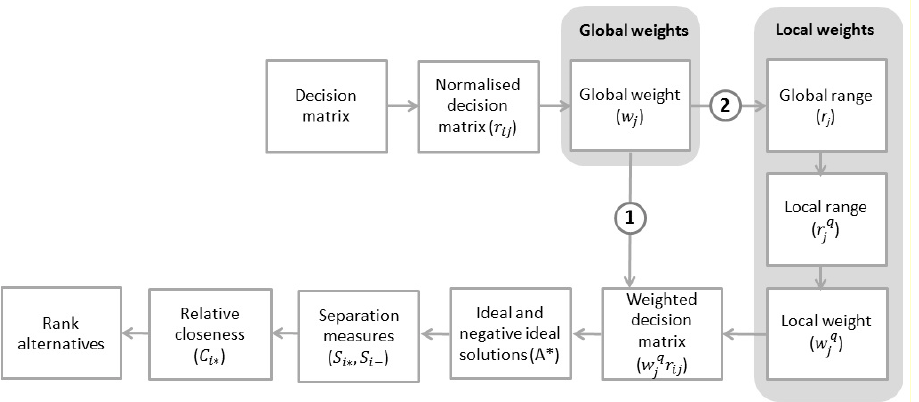
Figure 6. Graphical representation of the steps for applying TOPSIS using global (route 1) and local criteria weights (route 2).